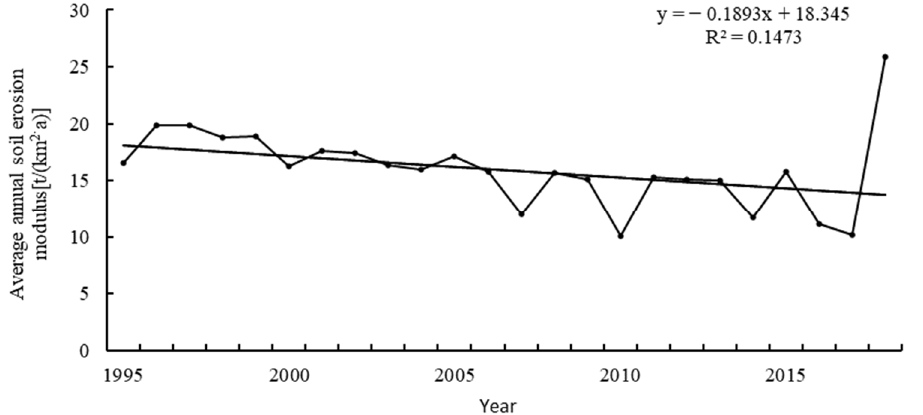
Figure 7. Time change of annual soil erosion modulus in the Northand SouthMountains of Lanzhou from 1995 to 2018.